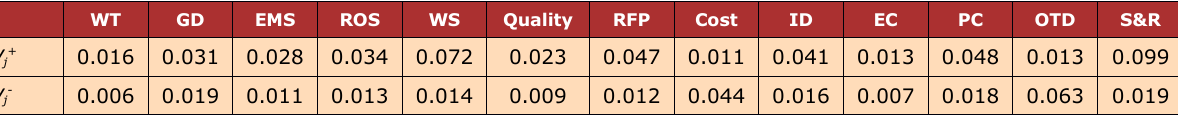
Table 14. Ideal positive and negative